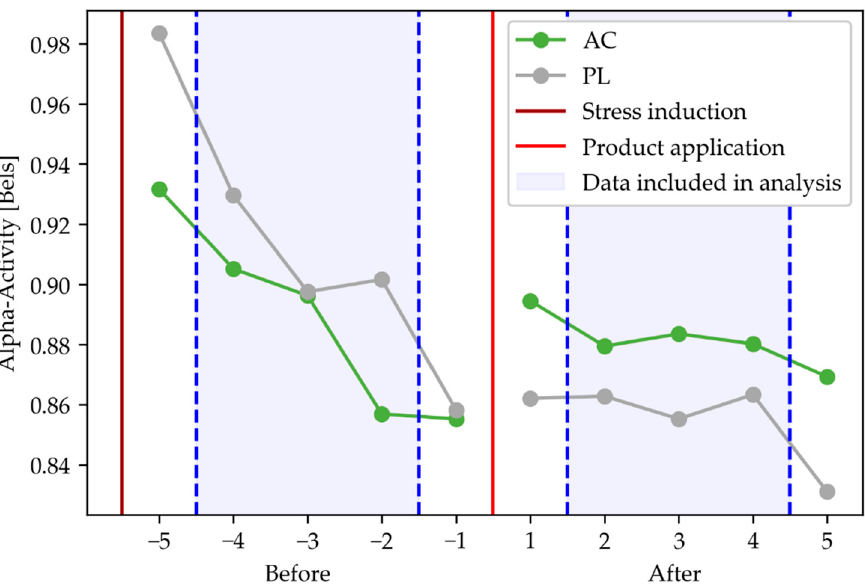
Figure 5. Alpha-activity in the frontal brain regions before and after the product application of the samples active compound (AC) and placebo (PL). Mean data from all subjects (N = 24) were pooled per minute and plotted as dots. The red line represents the product application. For the analysis, the blue areas between minute 2 and minute 4 were included, as this excluded any effects at the start of and towards the end of the measurement. At these times, interaction with the experimenter and the alarm clock took place and could have been an additional stress factor for the